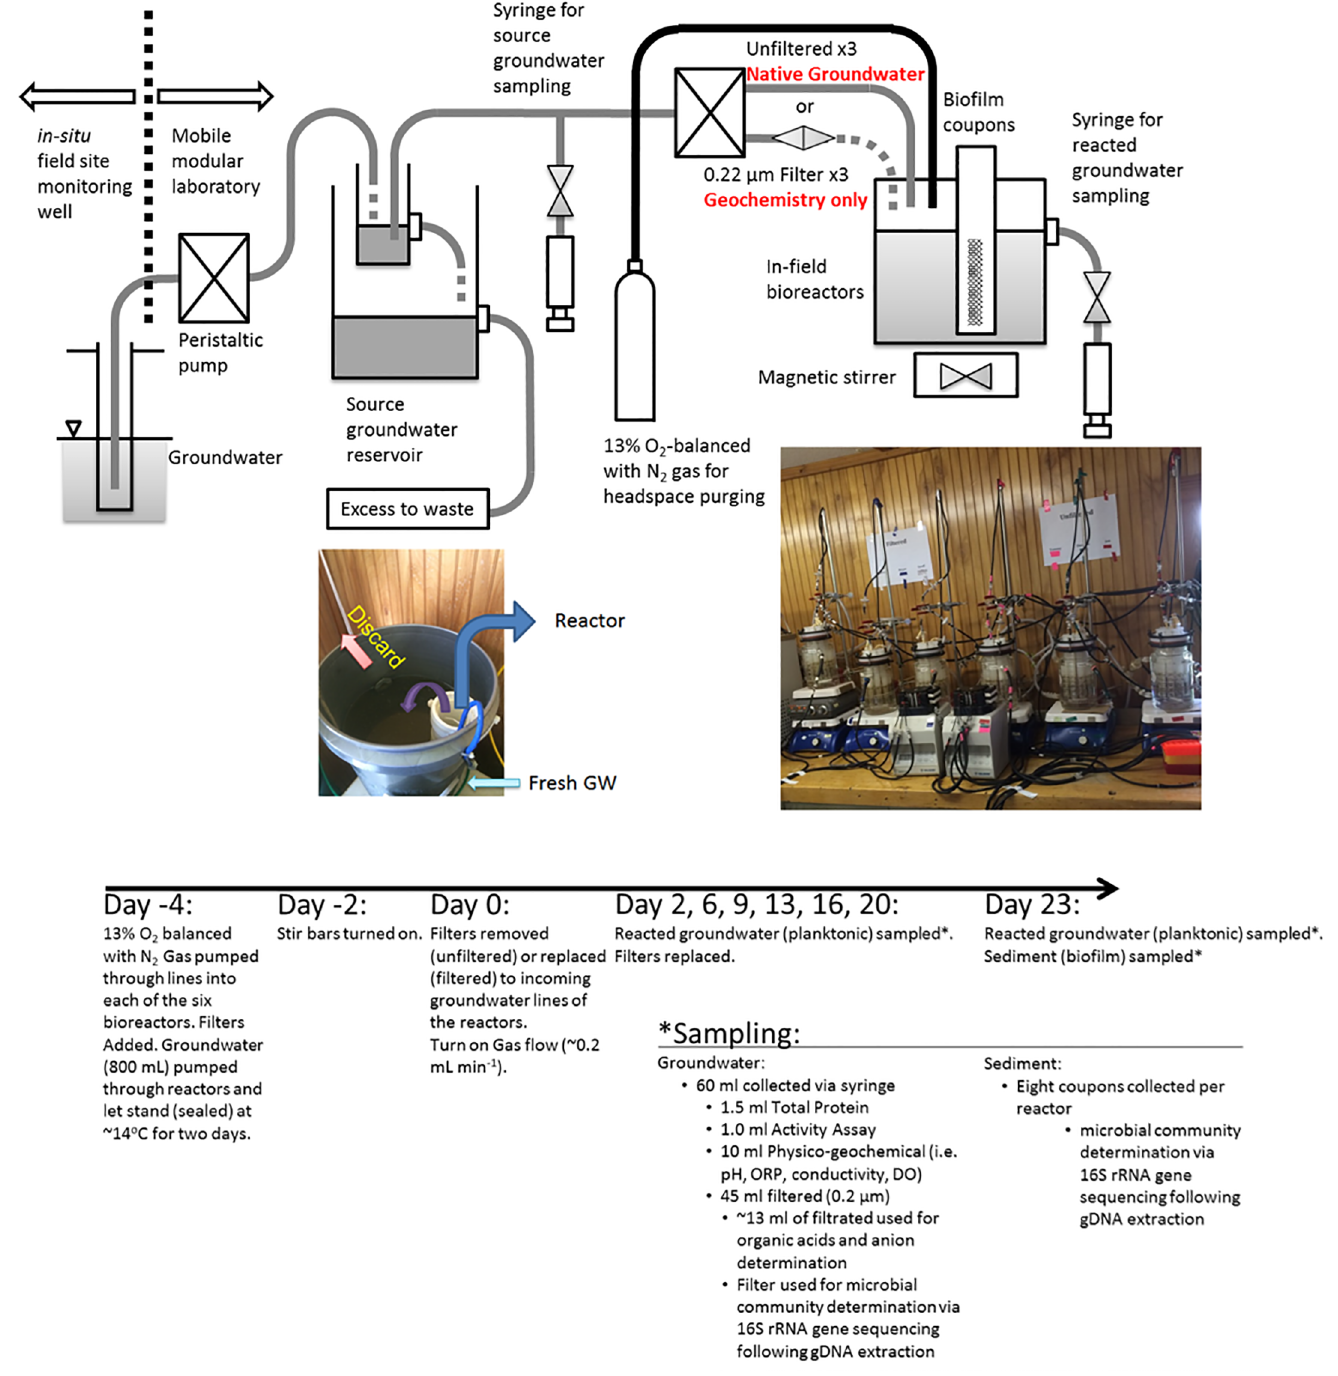
Fig 1. Experimental design. Schematic representation and description of the bioreactor setup and sampling schedule. added to the inflow lines of all bioreactors to prevent any excess dripping into the system, and bioreactors were acclimated for 48 hr. Bioreactors were incubated for an additional 48 hr with mixing with magnetic stir bars, but no groundwater flow. After this four-day acclima- tion period, water samples were collected (day 0) and gas flow started. At day 0, 60 mL water